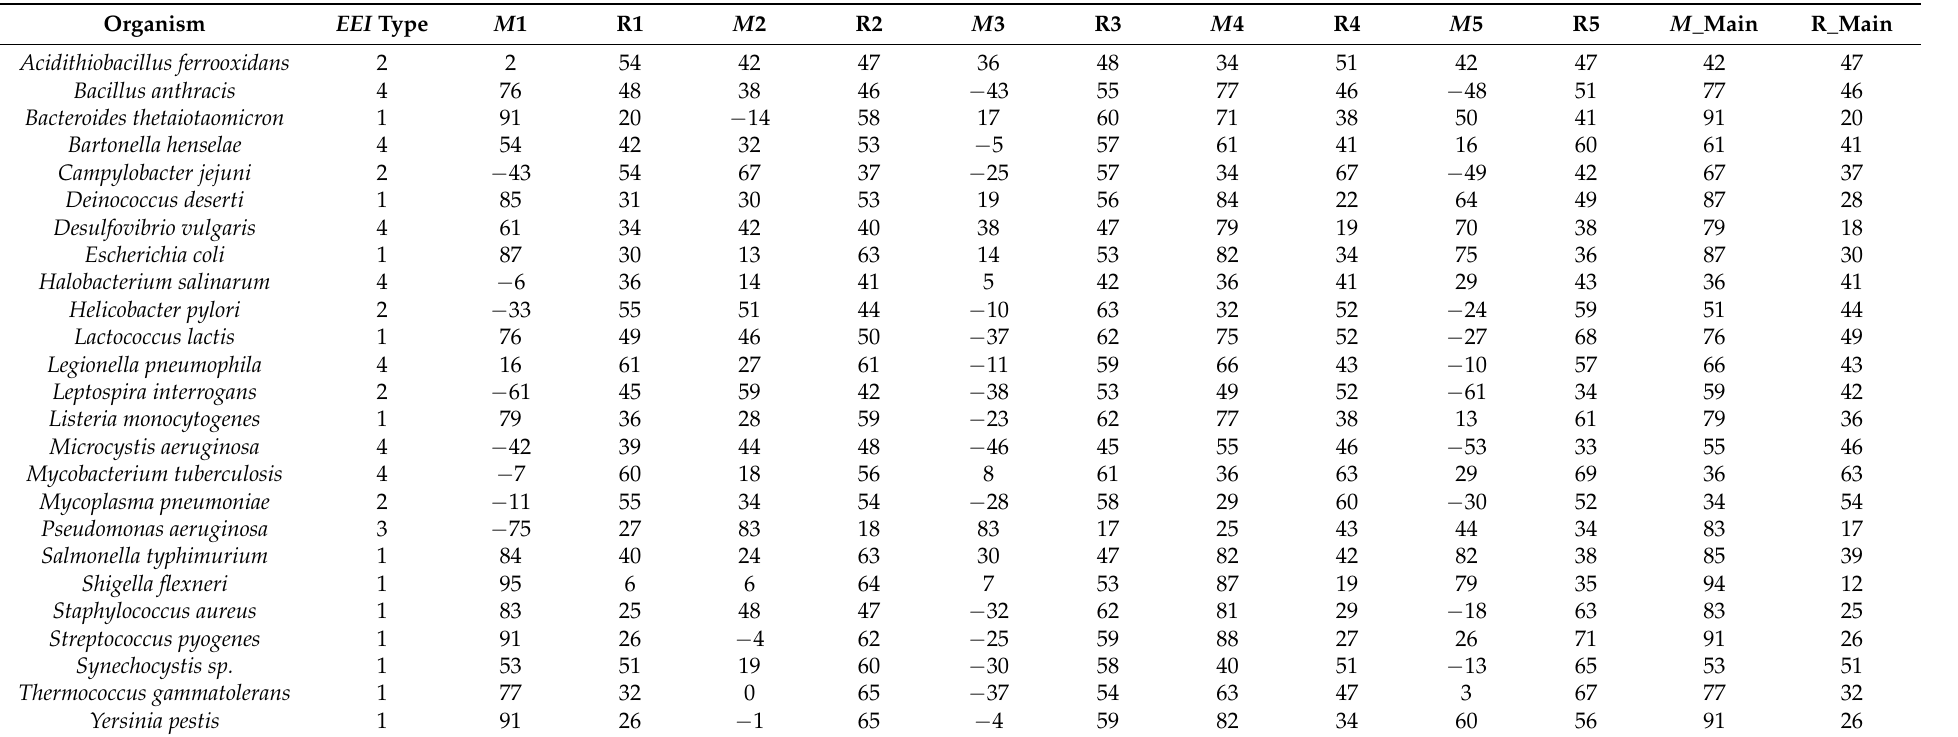
Table A2. The table represents M (the normalized mean rank of ribosomal genes) and R (the normalized standard deviation for ranks of ribosomal genes) calculated for each EEI type (1–5), the EEI type, and M and R values for the EEI type (the columns M_main,